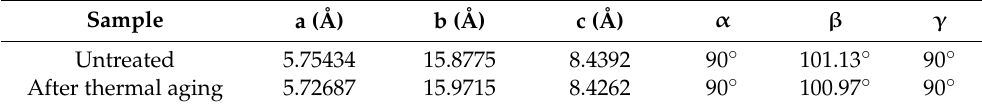
Figure 7. PDF curves and fitting results of two samples before and after thermal aging: ( a ) PDF curve of LLM-105 before and after thermal aging; ( b ) PDF fitting results of LLM-105; ( c ) PDF curve of HNS before and after thermal aging; ( d ) PDF fitting results of HNS. Table 2. Changes of LLM-105 crystal structure parameters before and after thermal aging.